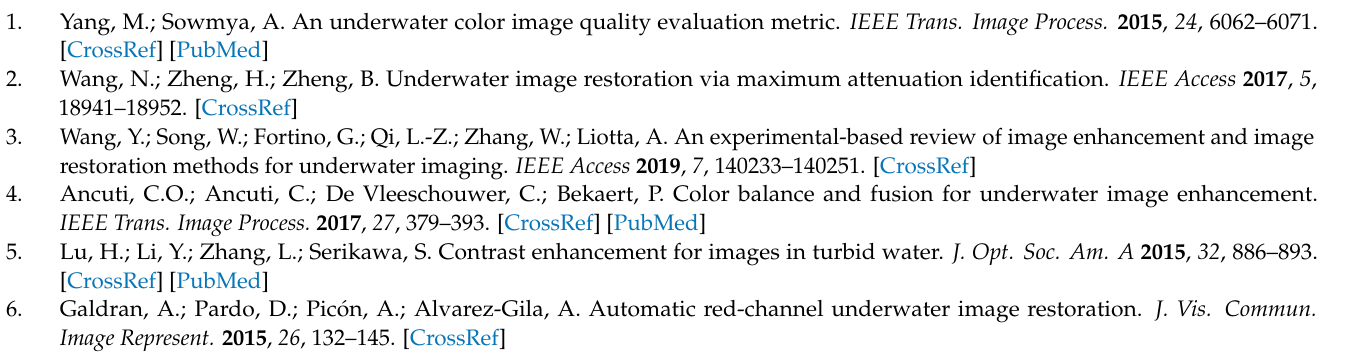
Figure 12. The first row contains the original pair of images with two SIFT features matching in the first column and one in the second column. The second row contains the enhanced pair of images using the proposed method with 16 SIFT features matching in the first and second columns.